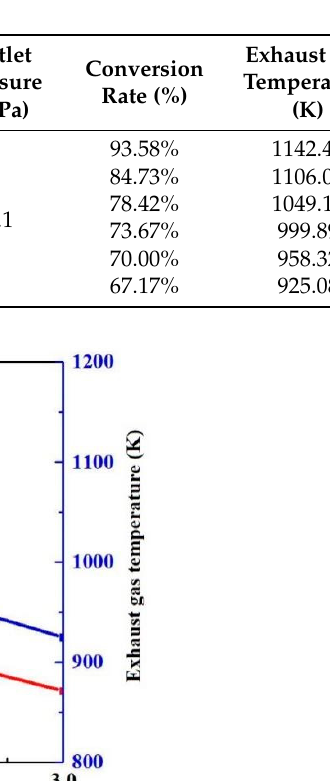
Table 4. Simulation parameters of the influence of injection rate on methane conversion rate and exhaust gas temperature.